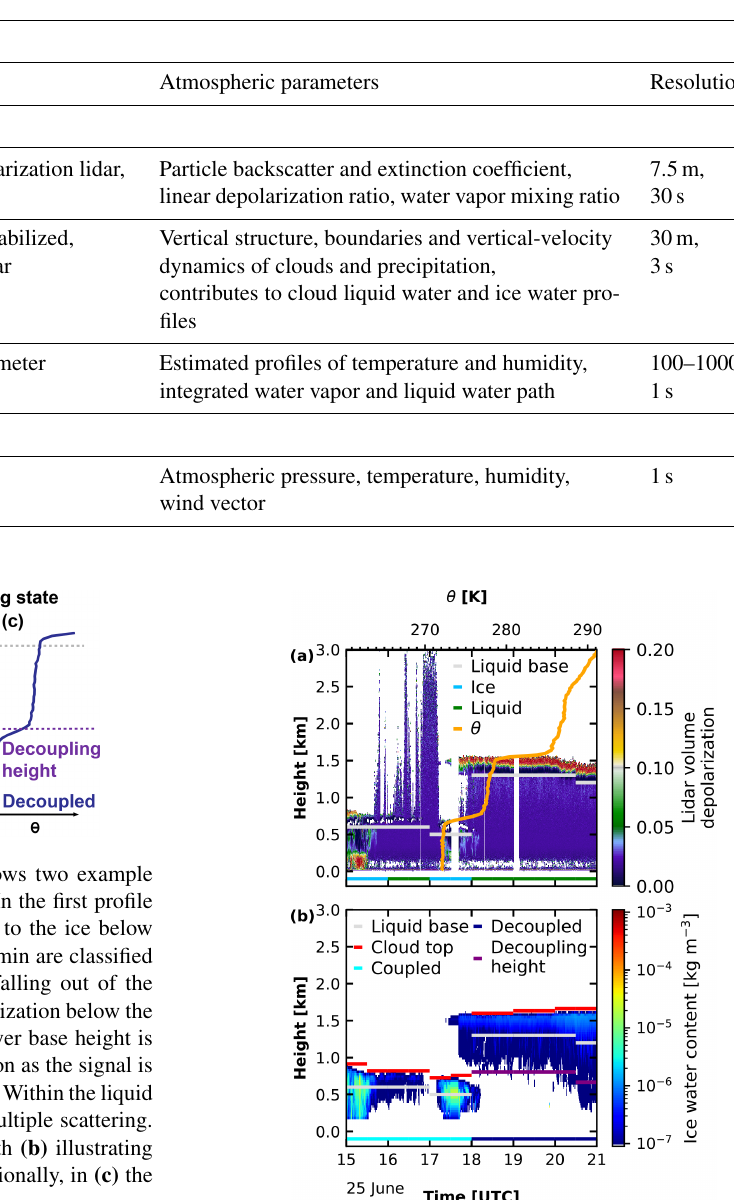
Table 1. Instrumentation used in the framework of this study.